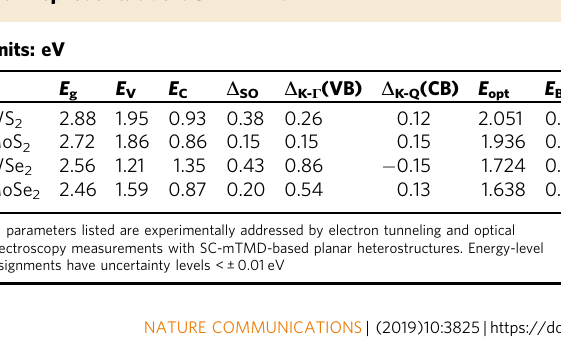
Table 1 Experimentally identi fi ed material parameters of the four representative SC-mTMDs Units: eV E g